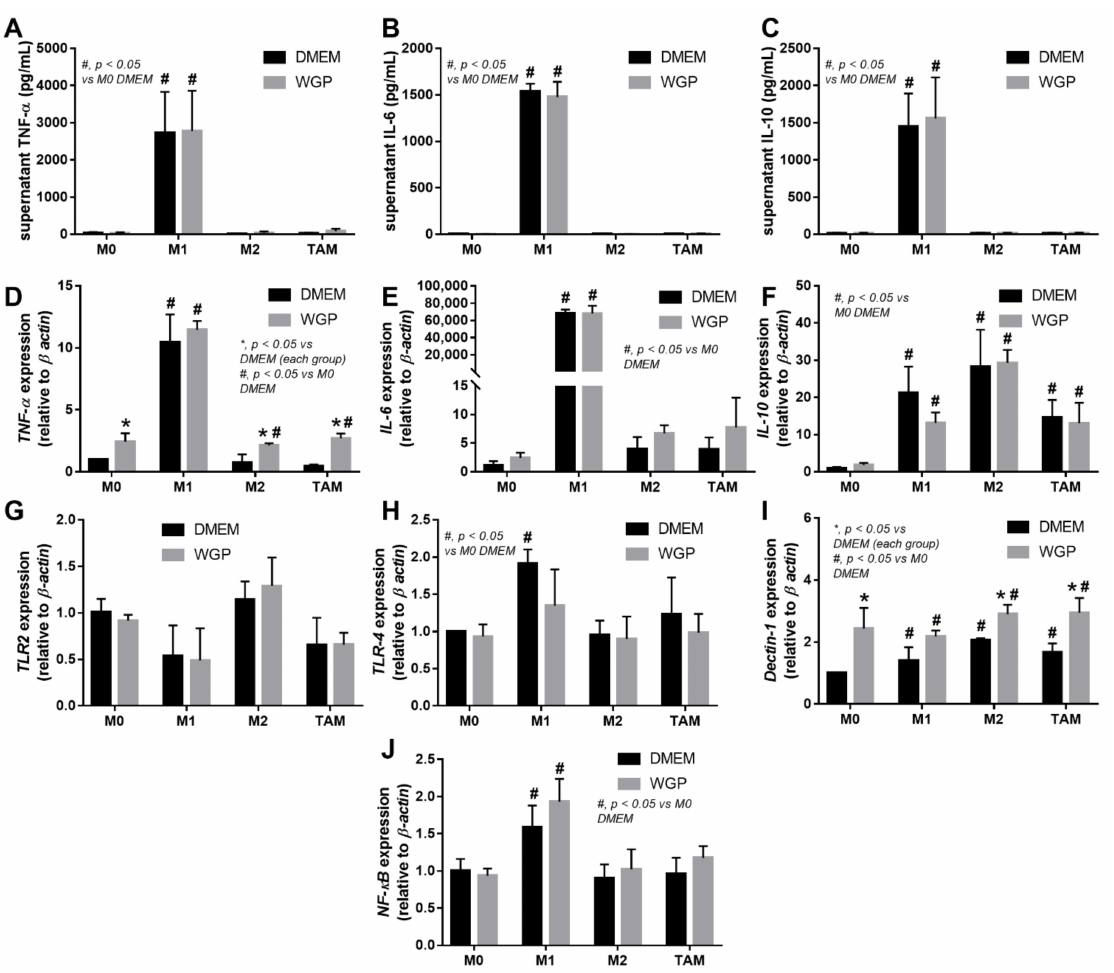
Figure 5. The characteristics of the in vitro experiments with the incubation of fluorescence-stained colon cancer cell line (MC38) with different bone marrow-derived macrophages of the wild-type mice, including M0 (incubation with DMEM control media), M1 (LPS activation), M2 (IL-4 stimulation), and tumor-associated macrophages (TAM; using MC38 supernatant), together with whole glucan particle (WGP) or DMEM media control, as indicated by supernatant pro-inflammatory cytokines ( A – C ) and gene expression ( TNF- α , IL-6, and IL-10 ) ( D – F ) with inflammatory signals ( TLR-2, TLR-4, Dectin-1, and NF κ B ) ( G – J ). Independent triplicate experiments were performed. *, p < 0.05 vs. DMEM in each group; #, p < 0.05 vs. M0